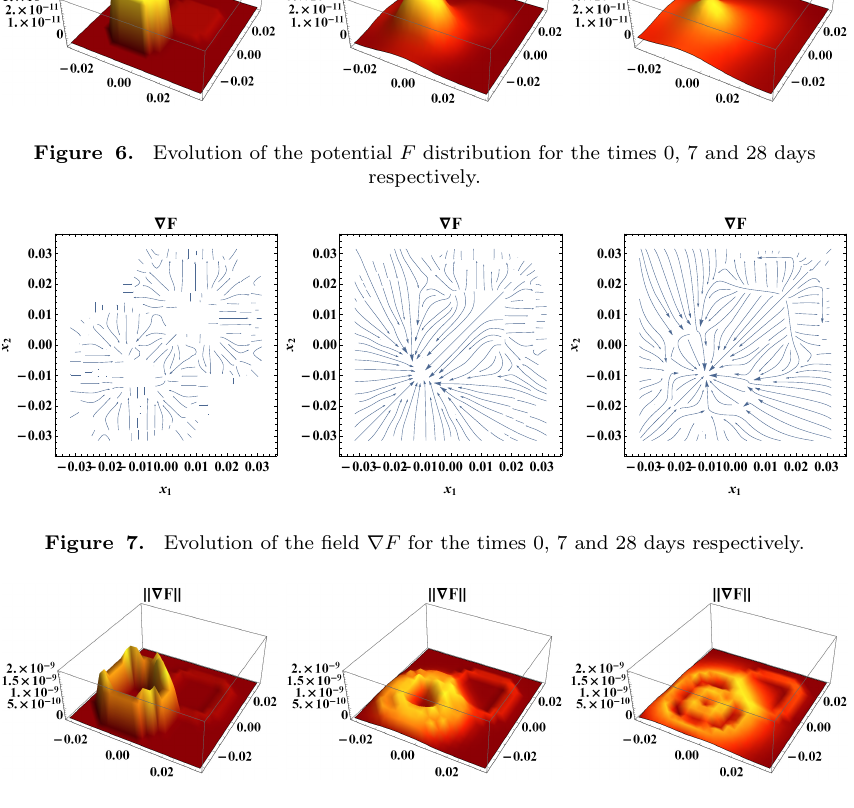
Figure 8. Evolution of the norm (cid:107)∇ F (cid:107) for the times 0, 7 and 28 days